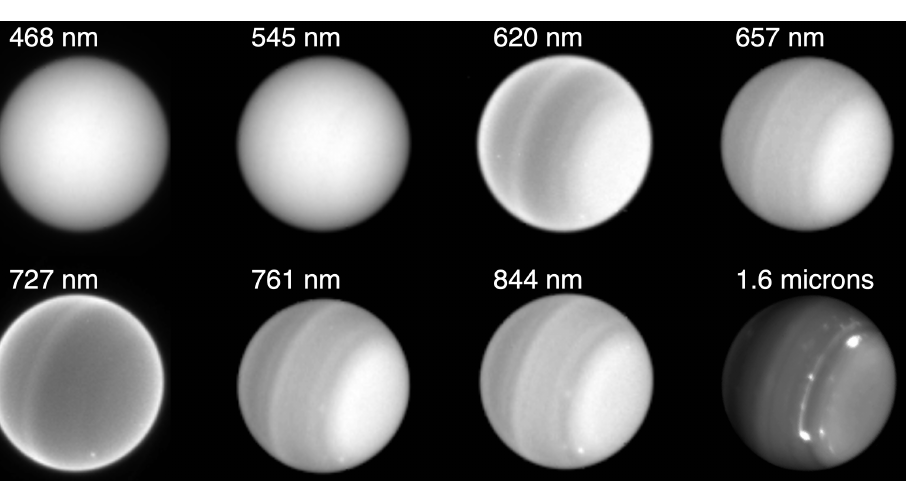
Figure 8. Uranus’s appearance at visible and near-IR wavelengths. September 2015 Hubble and August 2014 Keck data [24] show Uranus’s cloud band variations with wavelength. The north pole is to the right. Uranus is more uniform at short wavelengths than at long wavelengths, with banding and storm contrast increasing at longer